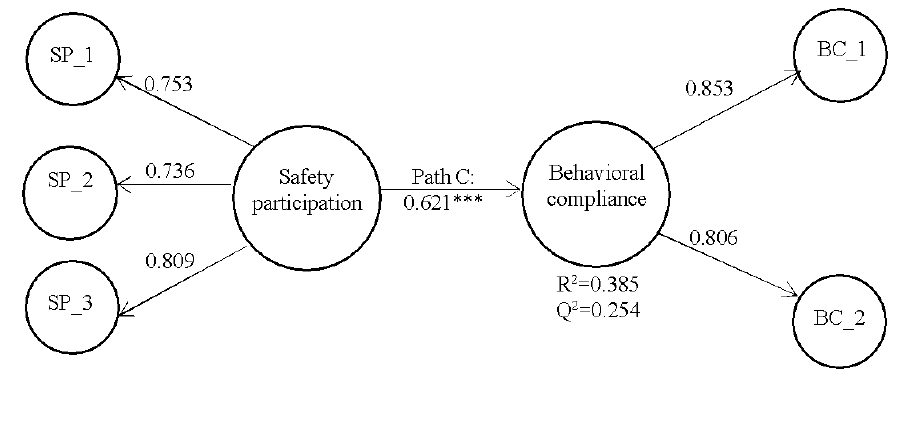
Figure 2. The direct effect model.